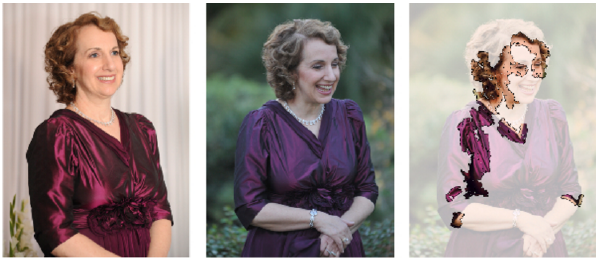
Fig. 8 Left, center: two input images with different color themes. Right: regions matched by NRDC [54]. Reproduced with permission from Ref. [54], c (cid:13) Association for Computing Machinery, Inc.